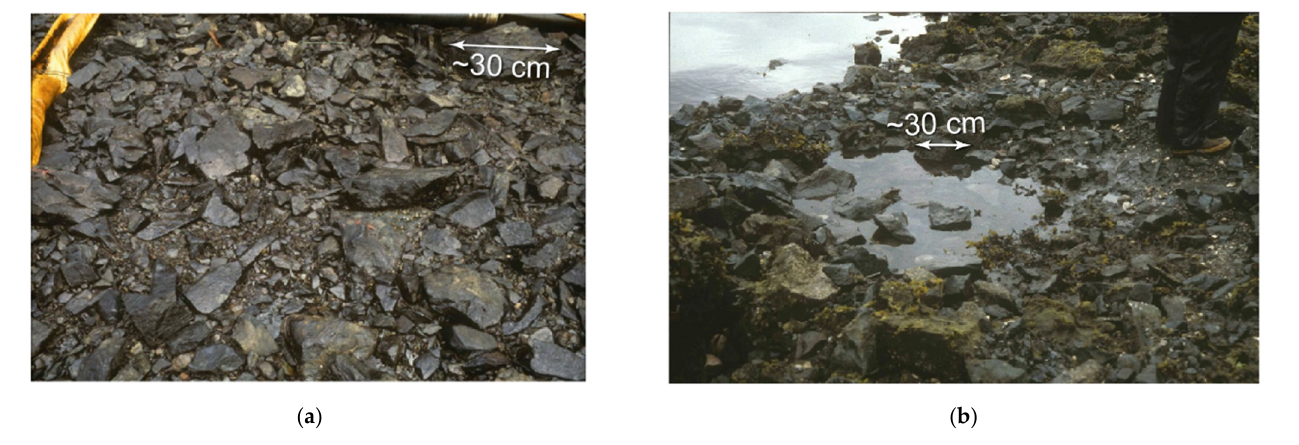
Figure 3. Photos of Disk Island (site DI63; see Figure 2), a heterogeneous gravel beach in western Prince William Sound, Alaska, in 1989. ( a ) Initial beach condition following oiling, but prior to high-pressure/hot-water (HP/HW) washing. Note that clasts in the surficial armored layer are largely oriented with their longest axes parallel to the beach (flat-lying), interstices between larger clasts are filled by finer gravel, and that clam shells are notably sparse. ( b ) This same beach ca. 48 h later, following HP/HW washing. Note the disorganized condition of surficial gravel and abundant exposed and fractured clam shells.